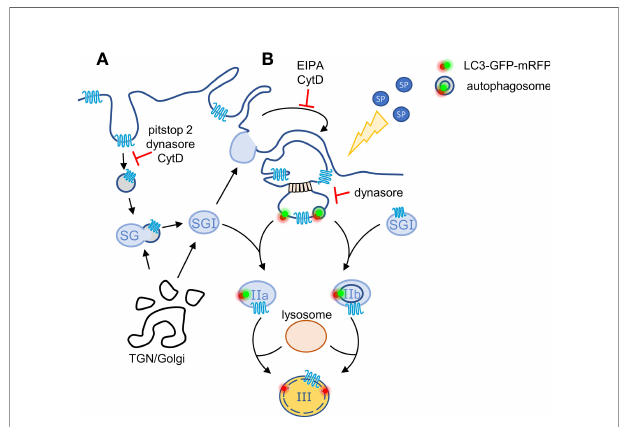
FIGURE 6 | Model for the crosstalk between macropinosomes and the SGs. According to our model, plasma membrane-localized MRGPRX2 internalizes in response to cell stimulation by SP by two parallel mechanisms: (A) by endocytosis that is partially sensitive to pitstop2 and (B) by macropinocytosis. Endosomes may fuse with the SGs, thereby delivering MRGPRX2 to the SGs, whereas MRGPRX2-containing vesicles bud from macropinosomes by a mechanism that involves dynamin and either the binding of cytosolic or phagophore associated LC3, or fusion with autophagosomes. These vesicles then fuse with TGN-derived SGs (Type I) generating respectively, Type IIa or Type IIb, LC3-positive SGs. The latter then acidify, most likely by their fusion with lysosomes, by a SP-stimulated process, generating Type III